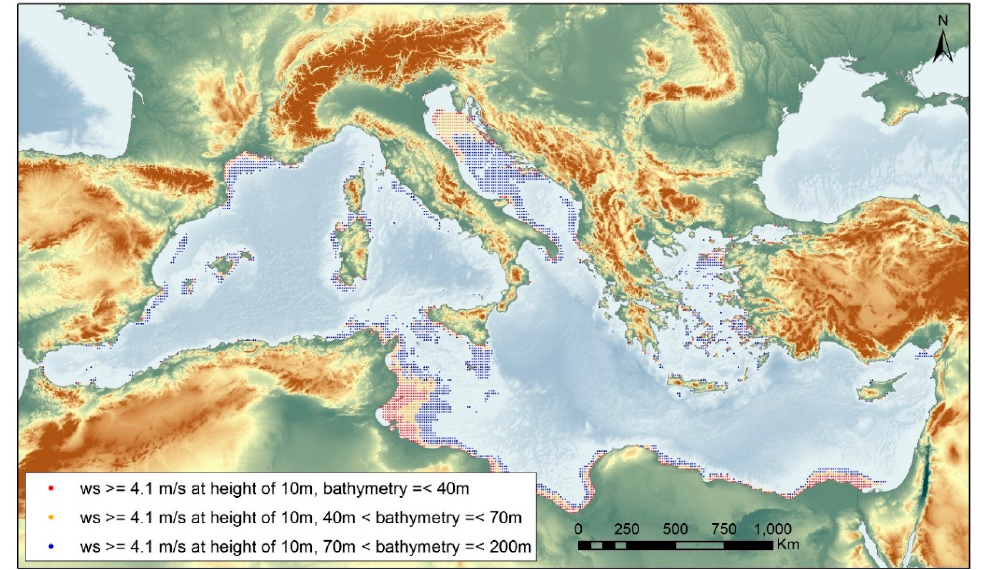
Figure 13. Potential hot-spots for OWF development in the Mediterranean Sea [107]. Data analyzed by HCMR.